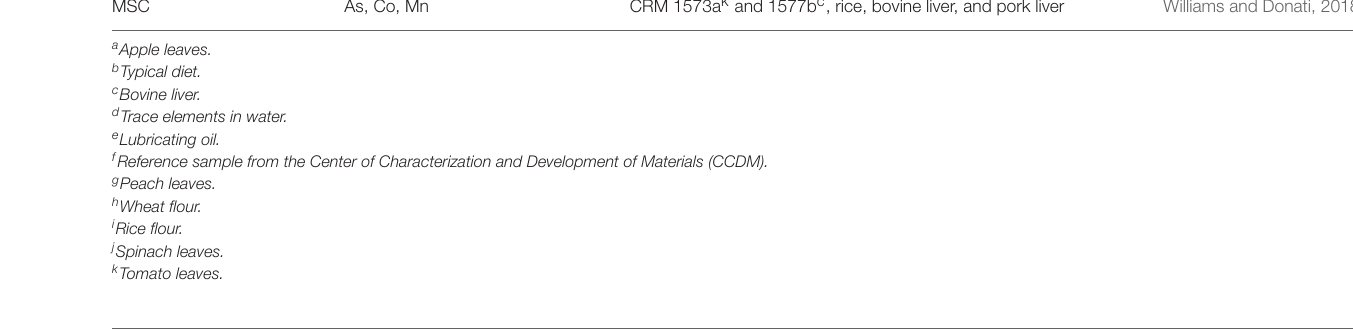
TABLE 5 | Advantages and potential limitations of IFS, SDA, MICal and MSC, and the instrumental methods in which they have been used. Calibration